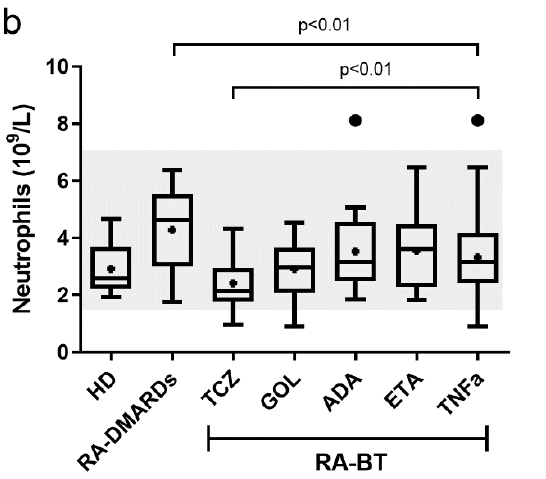
Figure 6: Different significance when comparing individual BTs and anti-TNFα as one group in